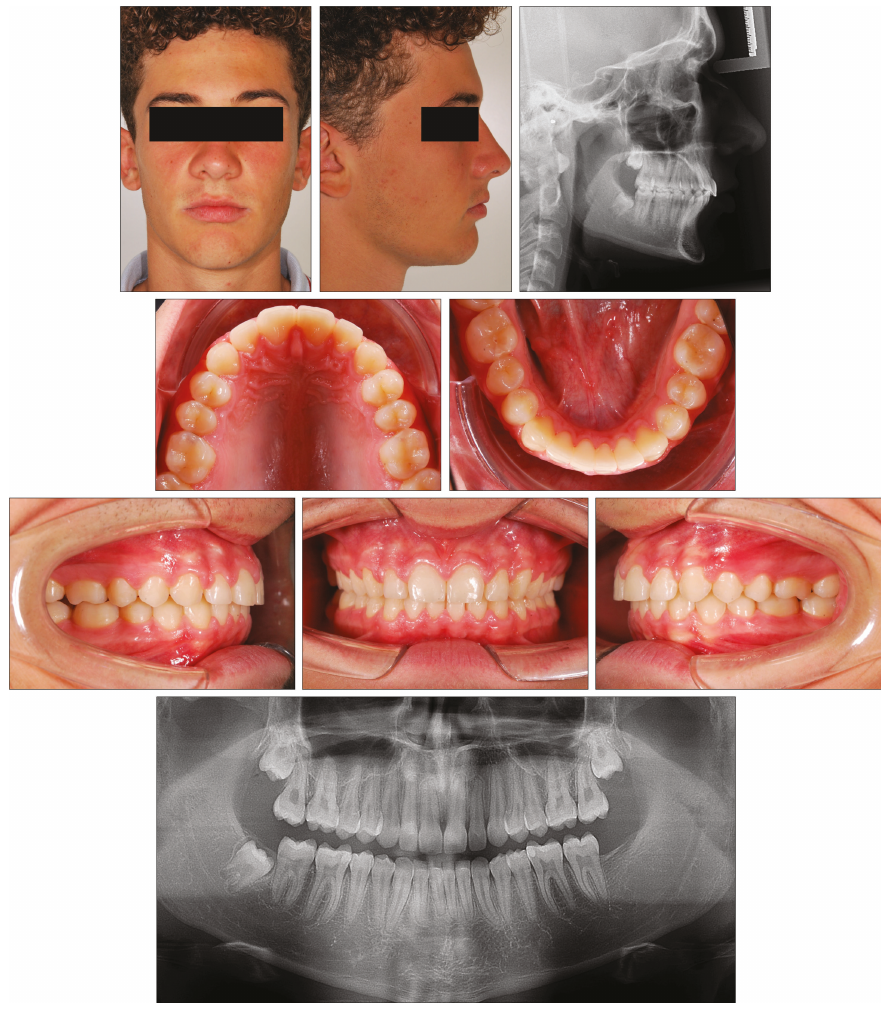
Figure 12: Case 3. Patient after 10 months of functional treatment with modi fi ed Twin-Block and 18 months of full- fi xed appliance treatment when he was 15 years and 6 months